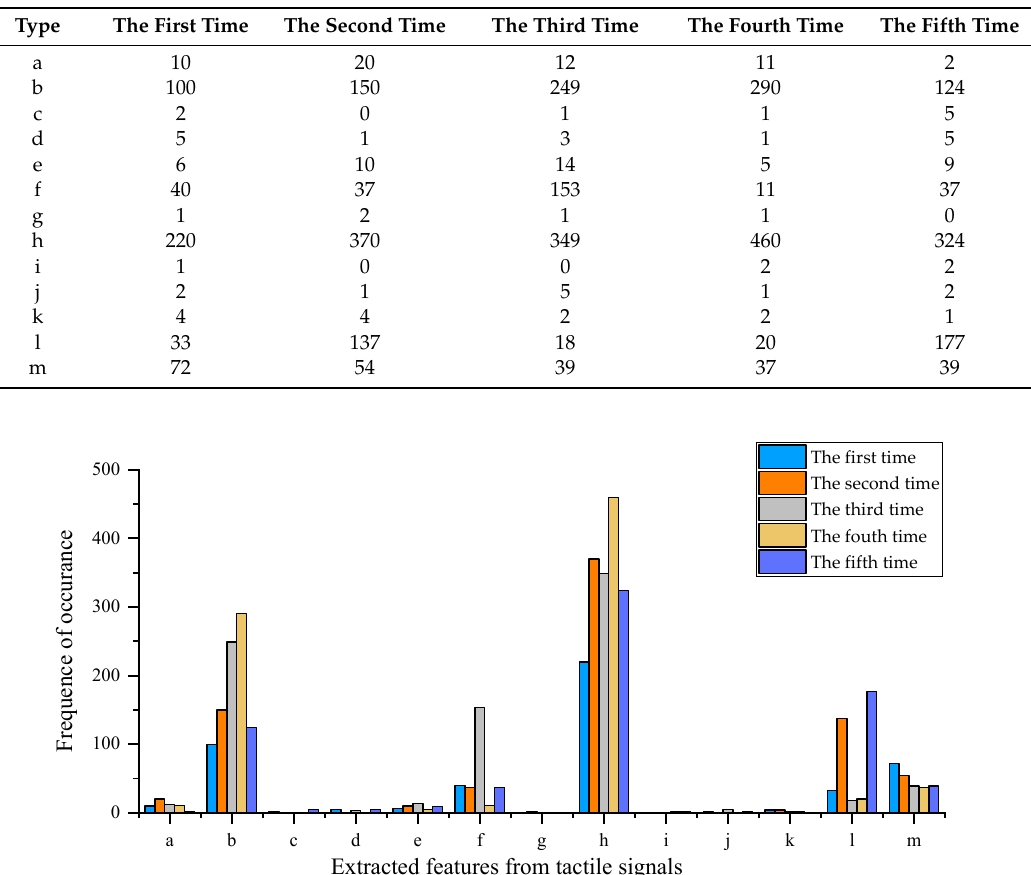
Table 8. Results of five times feature selection using the genetic algorithm.